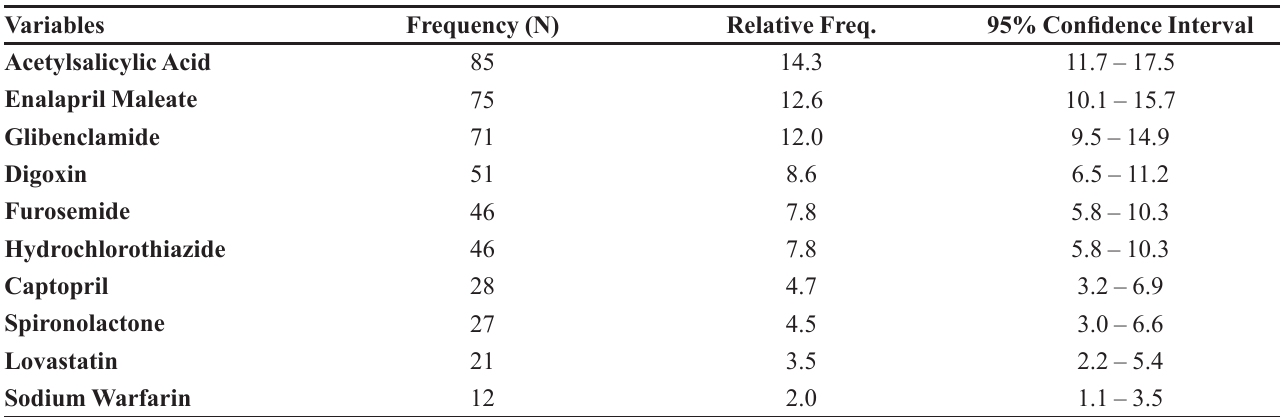
TABLE IV - Most frequent medications in interactions (n=590) Variables